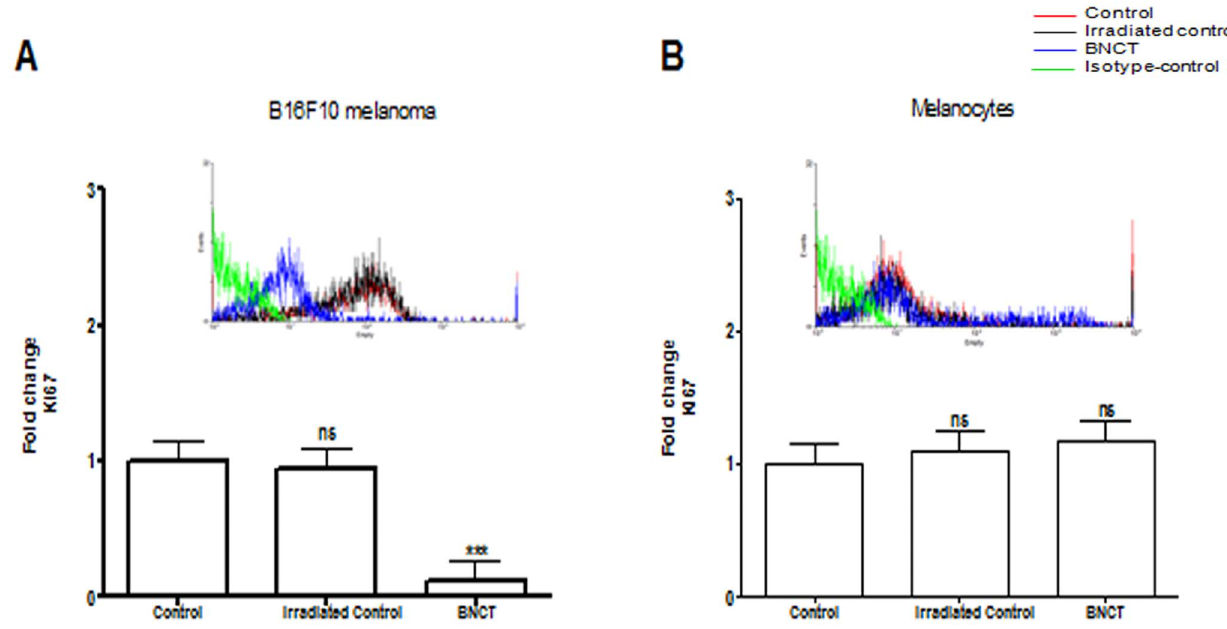
Figure 1. Expression of Ki67 in B16F10 melanoma cells and normal melanocytes (mean 6 s.d.) determined by flow cytometry. (A) Ki67 expression in B16F10 melanoma cells after BNCT treatment and neutron irradiation alone (irradiated control) compared to cells without any treatment (control). (B)Ki67 expression in normal melanocytes after BNCT treatment and neutron irradiation alone (irradiated control) compared to cells without any treatment (control). Cells incubated with FITC-conjugated isotype-specific antibodies were used as negative controls. ns: not significant compared to control. *p , 0.05; **p , 0.01; ***p , 0.001 compared to control.